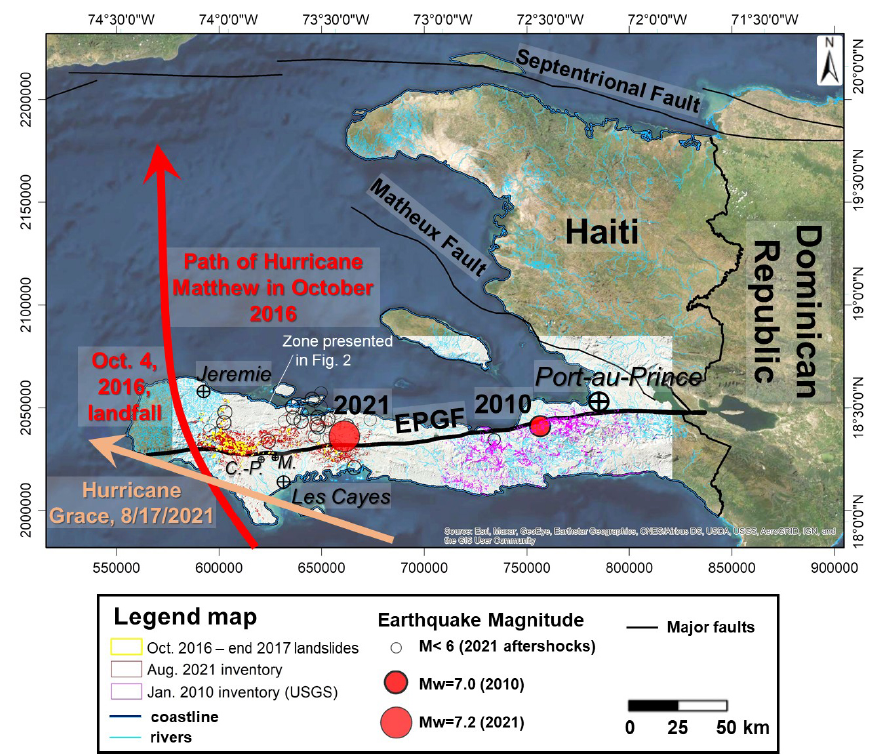
Figure 1. Location of the study region in Haiti: satellite image view of Haiti (© ESRI), with study region highlighted by the hillshade. See also location of the 2010 and 2021 epicenters, as well as the major cities (see also “C.-P.” for Camp-Perrin and “M.” for Maniche) hit by those two events. Outlines of major faults are shown as well as the indication of the approximate paths of Hurricane Matthew in October 2016 and of Hurricane Grace in August 2021. Landslides mapped by Harp et al. (2016) are shown by light-violet polygons, and recently mapped landslides triggered in August 2021 are outlined in dark red. See also location of the zone presented in Fig.